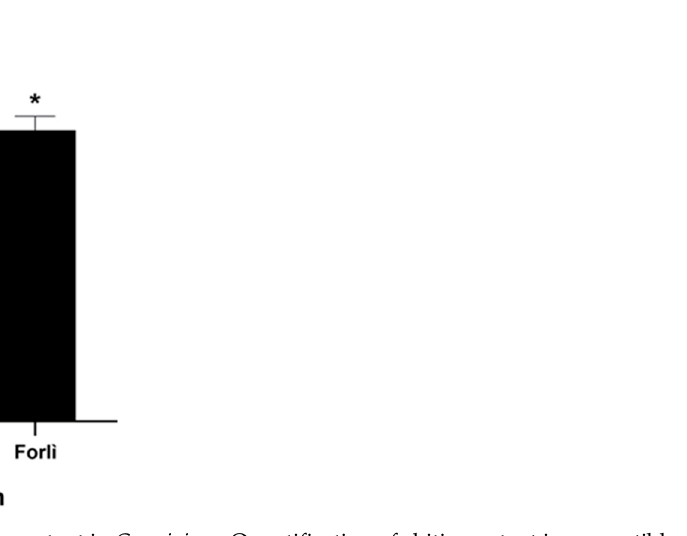
Figure 3. Analysis of chitin content in Cx. pipiens . Quantification of chitin content in susceptible and resistant mosquitoes. The values reported are the mean ± standard errors (* p < 0.001, Student’s t - test).